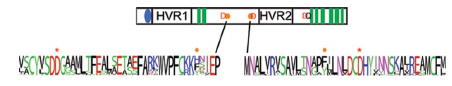
FiGuRe 5 | Residues with conserved aromatic property but not amino acid identity. The location of positions in the global alignment with strong aromatic property but not strong conservation of identity are marked by a orange hexagon on the schematic of the CesA protein. Shown in red are the conserved aspartate residues identified as important to catalysis in family 2 processive glycosyltransferases. The black Q marks the location of the QxxRW motif. Shown below this are frequency plots derived from the alignment of all CesA, CslD, and CslF sequences in this region. The amino acid with conserved aromatic property is labeled with an orange hexagon above it. The aspartate identified as important in the D,D,D,QxxRW motif is identified with a